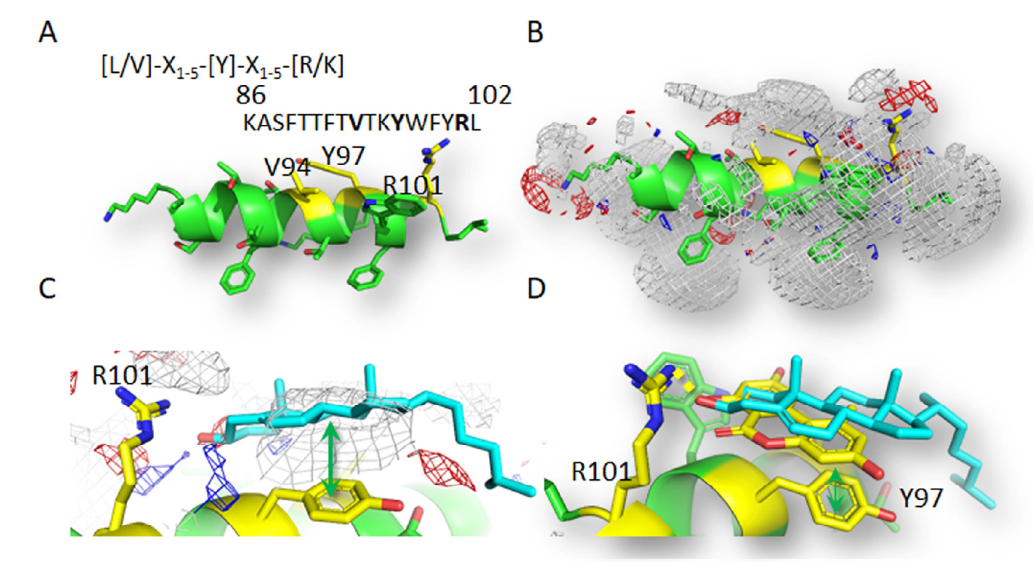
Figure 5. CRAC motif and the modeled CRAC portion of caveolin 1’s CSD domain. ( A ) CSD sequence containing the CRAC motif is shown and the conserved residues are highlighted in bold. ( B ) The protein is represented in sticks and cartoon, while gray, red and blue meshes indicate regions sterically and energetically able to receive hydrophobic, H-donor acceptor and H-bond donor groups, respectively. ( C ) Calculated interaction of cholesterol (represented in cyan sticks) at the CRAC portion of caveolin 1’s CSD domain. The protein is represented in sticks and cartoon, while gray, red and blue meshes indicate regions sterically and energetically able to receive hydrophobic, H-donor acceptor and H-bond donor groups, respectively. The green arrow indicates the formation of hydrophobic stacking, while the yellow dotted line indicates the formation of polar interaction. ( D ) Calculated interaction of AOH (represented in yellow sticks) overlapped to the calculated pose of cholesterol (represented in cyan sticks) at the CRAC portion of caveolin 1’s CSD domain. The green arrow indicates the formation of hydrophobic stacking, while the yellow dotted line indicates the formation of polar